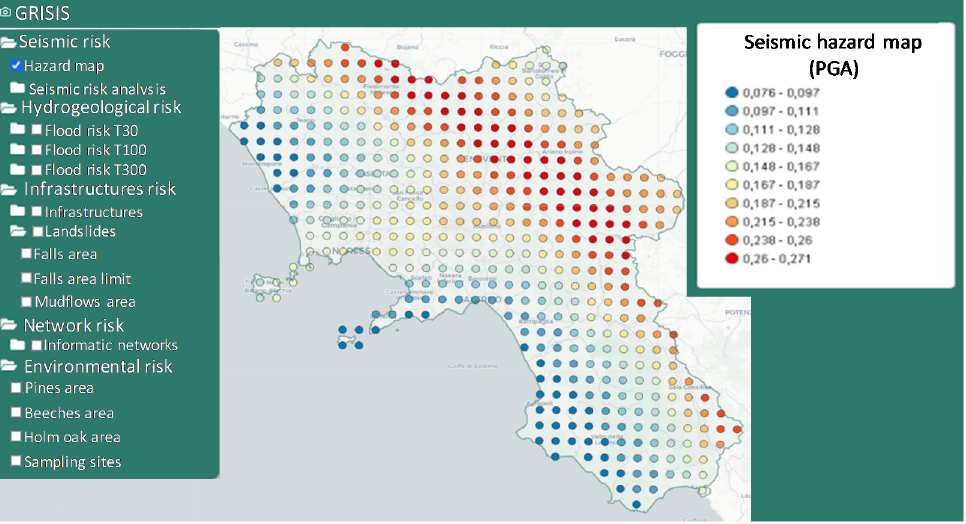
Figure 5. Seismic hazard map.